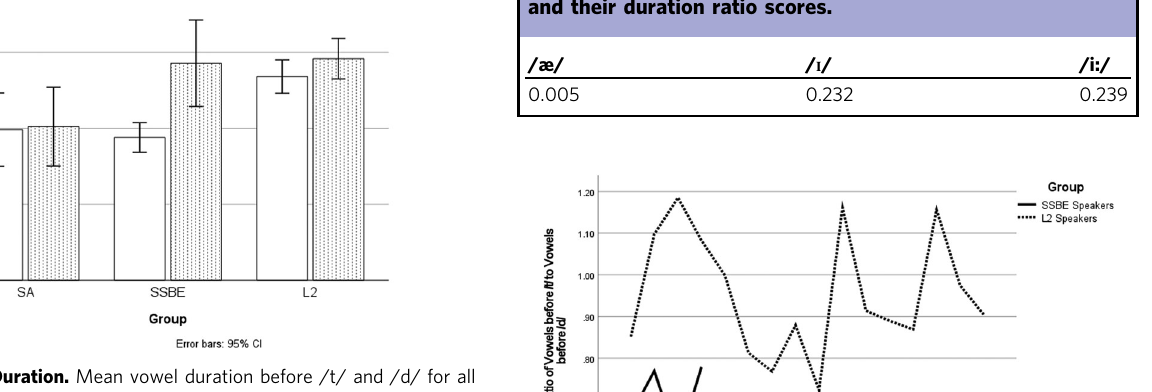
Table 2 Pearson r correlations between the L2 speakers ’ LoR and their duration ratio scores.